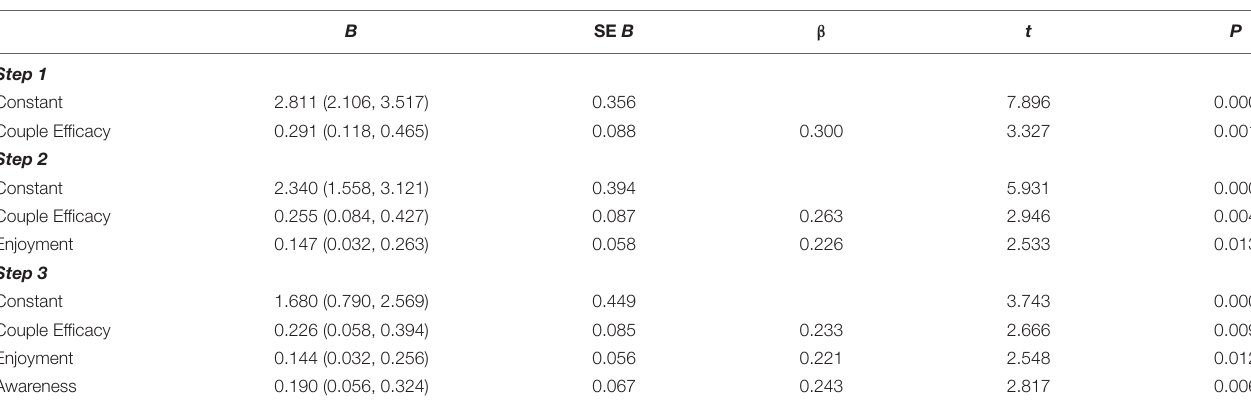
TABLE 2 | Hierarchical Regression Analysis considering Self-Efficacy as the variable